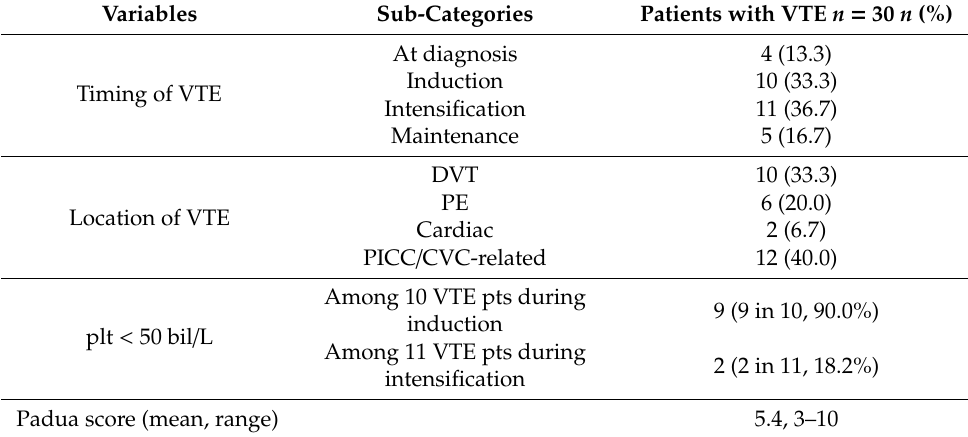
Figure 3. VTE site distribution throughout treatment phase. Dx = diagnosis; IND = induction; INT = intensification; Maint = maintenance.